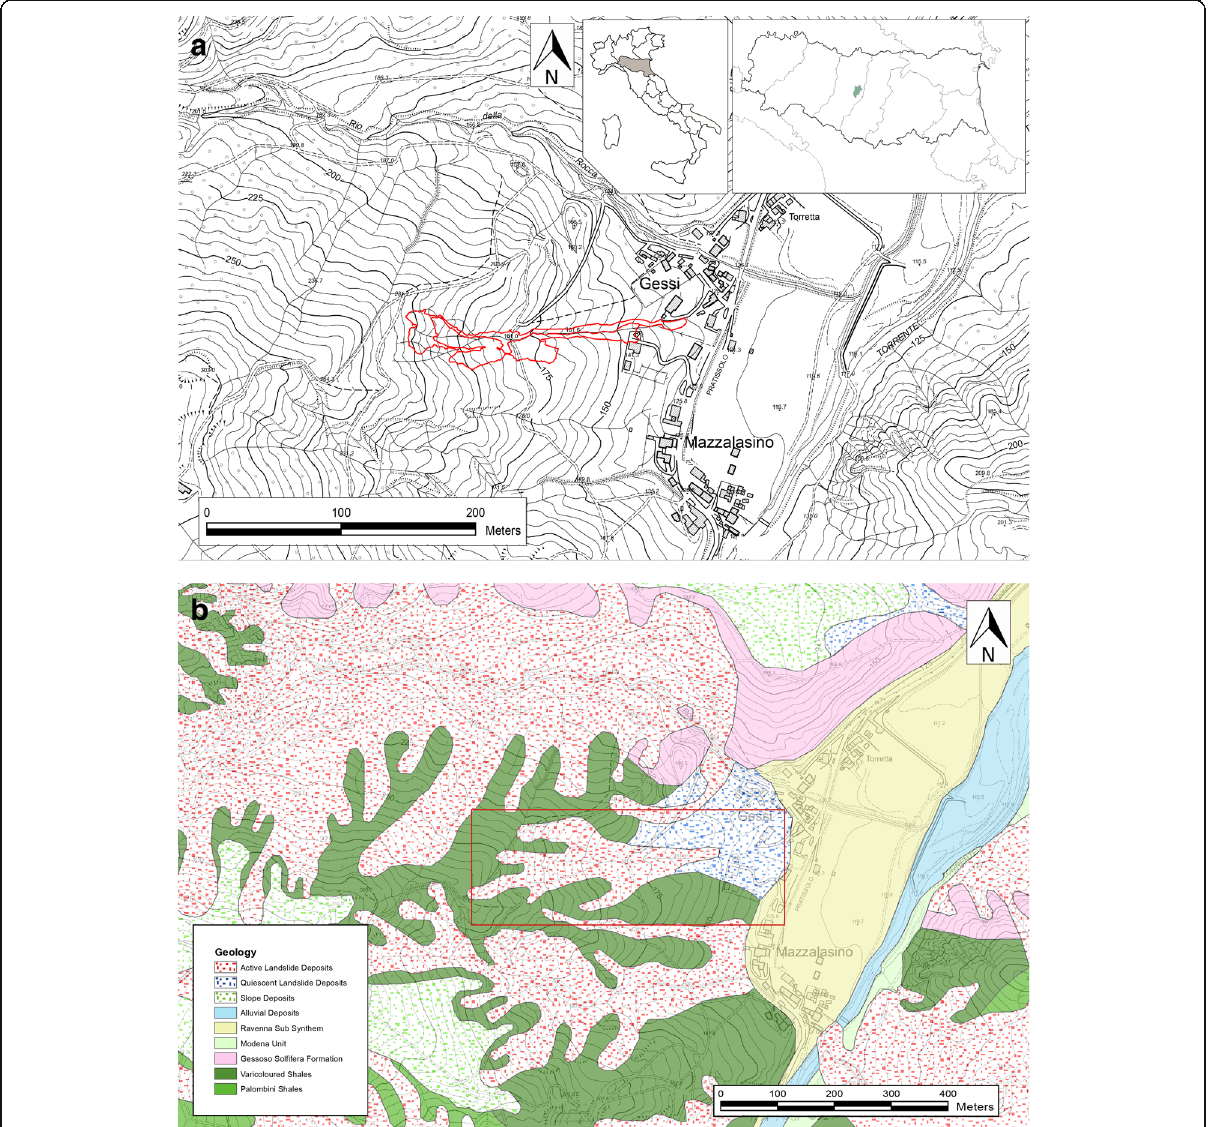
Fig. 1 a Topographic map and b ) geological map of the study area (from Servizio Geologico Sismico e dei Suoli, Emilia Romagna region,